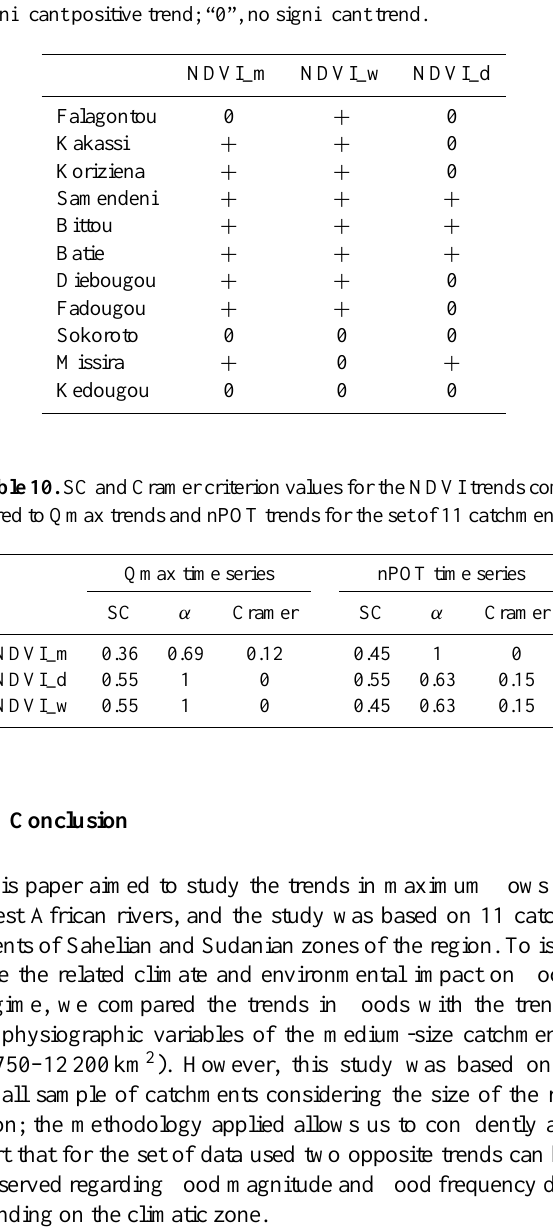
Table 9. NDVI time series trends for the 11 catchments studied over the period 1981–2006 according to the Mann–Kendall tests: “ + ”, significant positive trend; “0”, no significant trend.